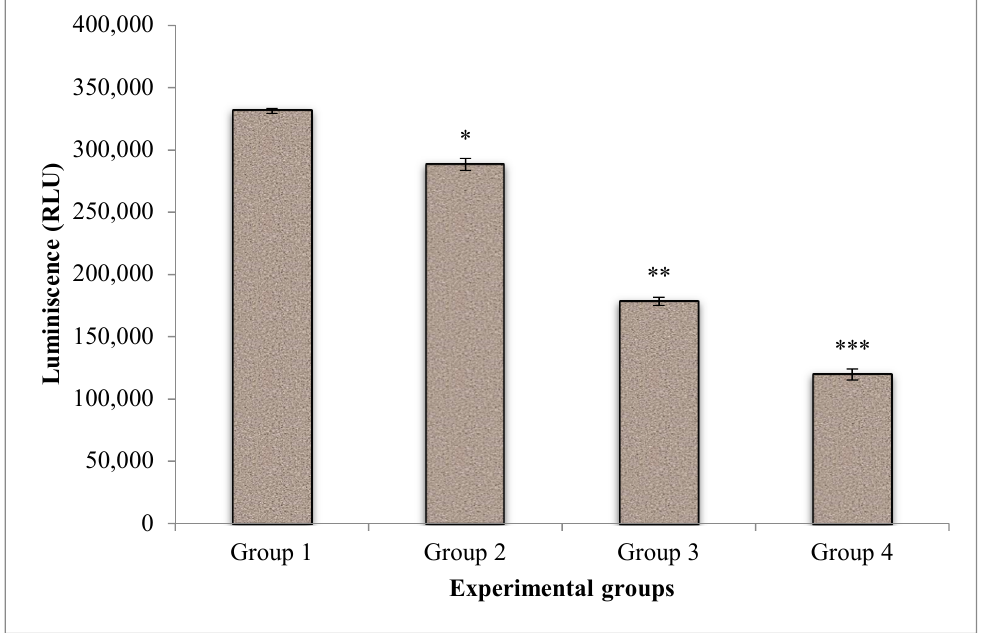
Table 1. Effect of CA in PDT on percentage cell viability and cytotoxicity of lung cancer cells. Groups Cell Viability (Trypan Blue) Cytotoxicity (LDH Leakage) Percentage (%) Absorbance @490 nm Group 1 98.24 ± 0.84 0.08 ± 0.02 Group 2 84.77 ± 0.39 * 0.34 ± 0.01 * Group 3 51.43 ± 0.72 ** 0.76 ± 0.14 ** Group 4 27.80 ± 1.56 *** 1.53 ± 0.52 *** Figure 6. Effect of CA on cell proliferation of A549 cells in PDT of lung cancer cells. The amount of cellular ATP was estimated in terms of Relative Light Units (RLU). A dose-dependant decrease in the ATP luminescence corresponding to the cell proliferation in CA treated A549 cells was observed. Group 1 (Control), untreated cells; group 2, laser control (5 J / cm 2 ); group 3 (PDT), PS (15 µ M) + laser (5 J / cm 2 ); group 4 (Phyto-PDT), CA (52 µ M) + PS (15 µ M) + laser (5 J / cm 2 ); Values presented as mean ± SE from independent duplicate experiments; n = 4. * p < 0.05, ** p < 0.01 and *** p <